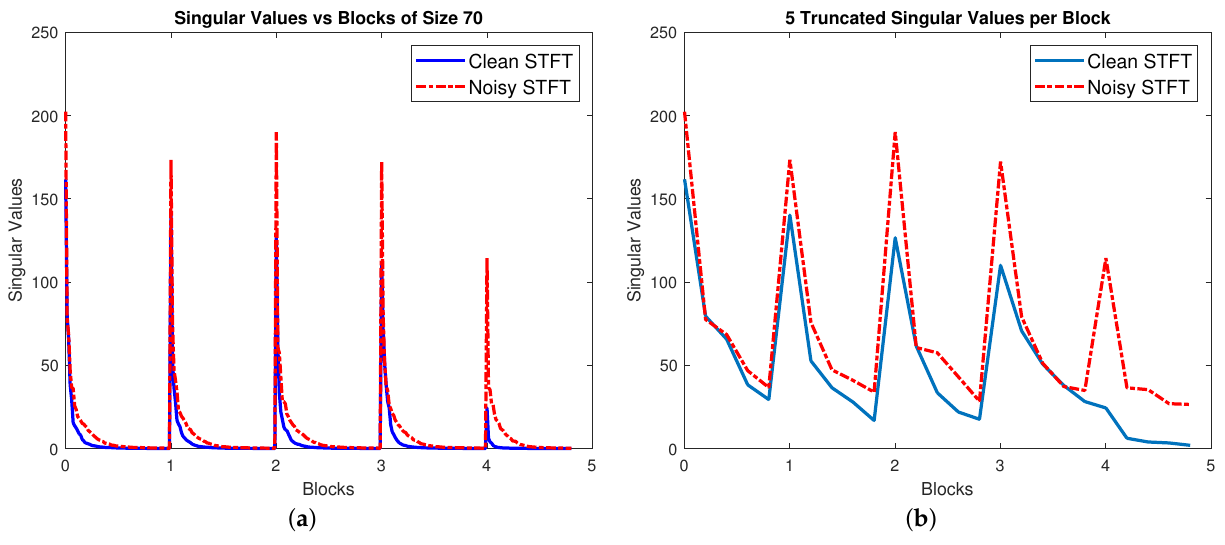
Figure 5. ( a ) Singular values corresponding to every block, and ( b ) the truncated singular values per block used for the approximated STFT ˆ X shown in Figure 6a.